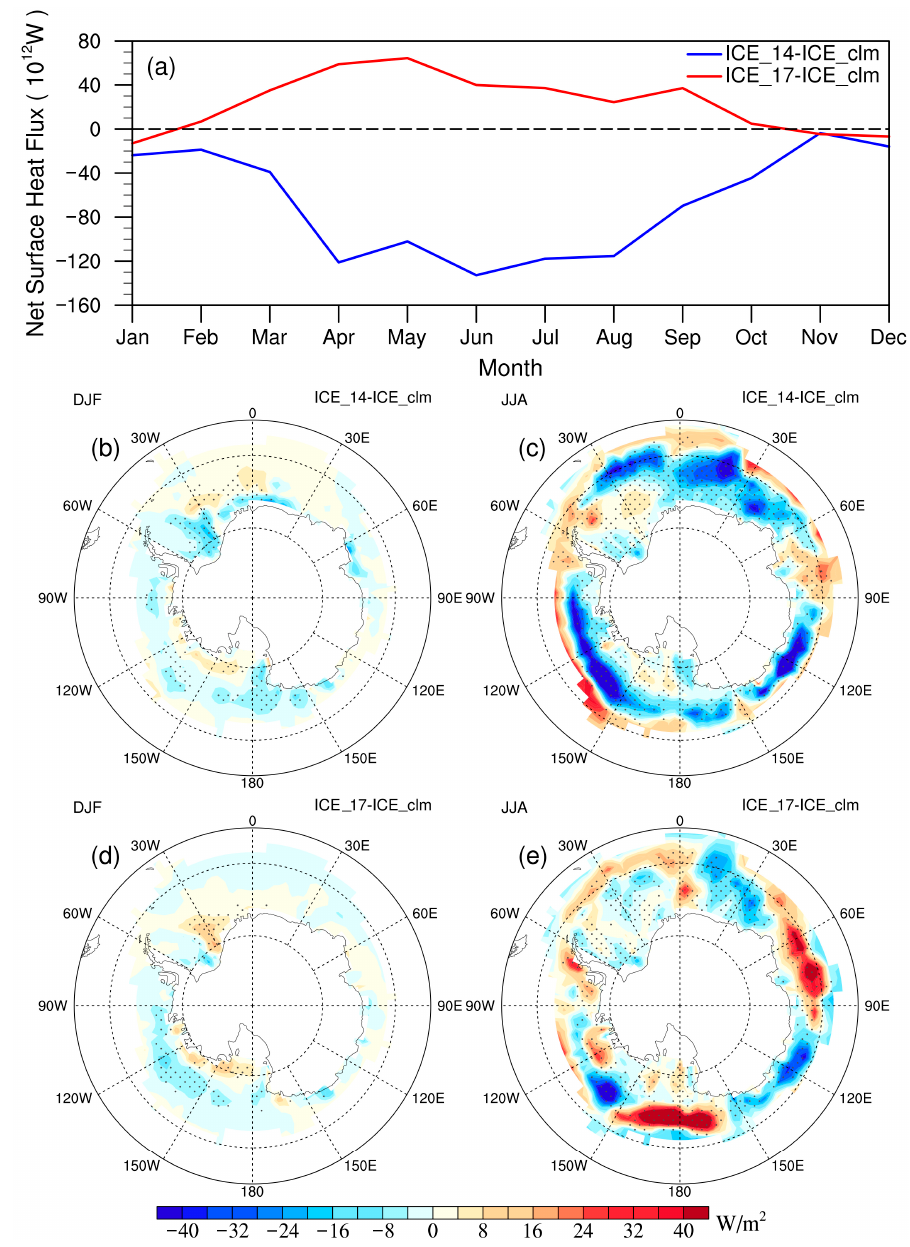
Figure 2. Changes in the net surface heat flux (the sum of the latent heat flux, the sensible heat flux, and the longwave flux over all grids where the sea ice changes) as a result of changes in Antarctic sea ice. ( a ) Difference in the total Antarctic net heat flux between ICE_14 and ICE_clm (blue line) and between ICE_17 and ICE_clm (red line). Spatial difference between ICE_14 and ICE_clm in the austral ( b ) summer and ( c ) winter. Spatial difference between ICE_17 and ICE_clm in the austral ( d ) summer and ( e ) winter. Positive means an upward flux from the ocean to the atmosphere. The dotted areas were statistically significant at the 95% confidence